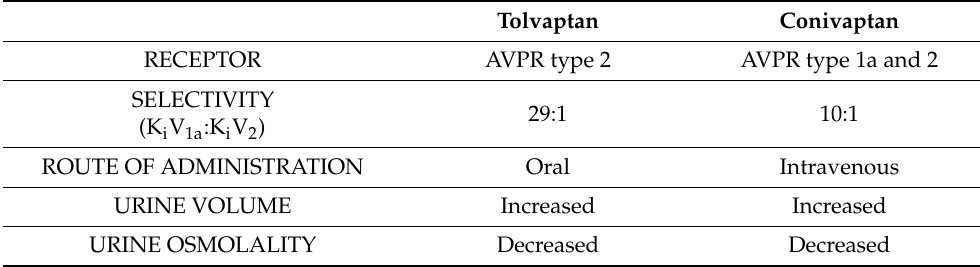
Table 1. Tolvaptan and